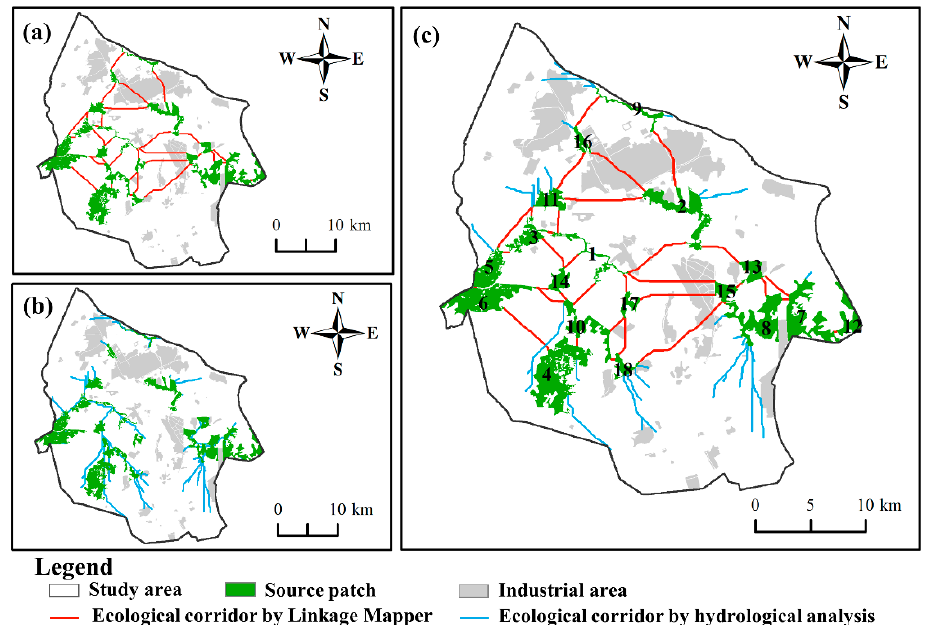
Figure 9. Distribution of ecological corridors: ( a ) identified by Linkage Mapper; ( b ) identified by hydrological analysis (HA); and ( c ) the potential ecological corridors combining results from the Linkage Mapper and HA.